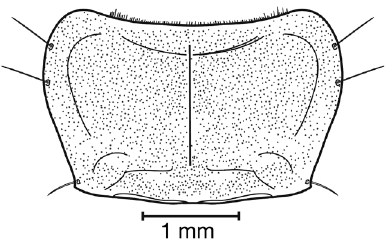
Figure 83. Line drawing, dorsal view, showing the form and 3 pairs of latero-marginal setae of the pro- notum of Horniulus andrewesi Jedlička